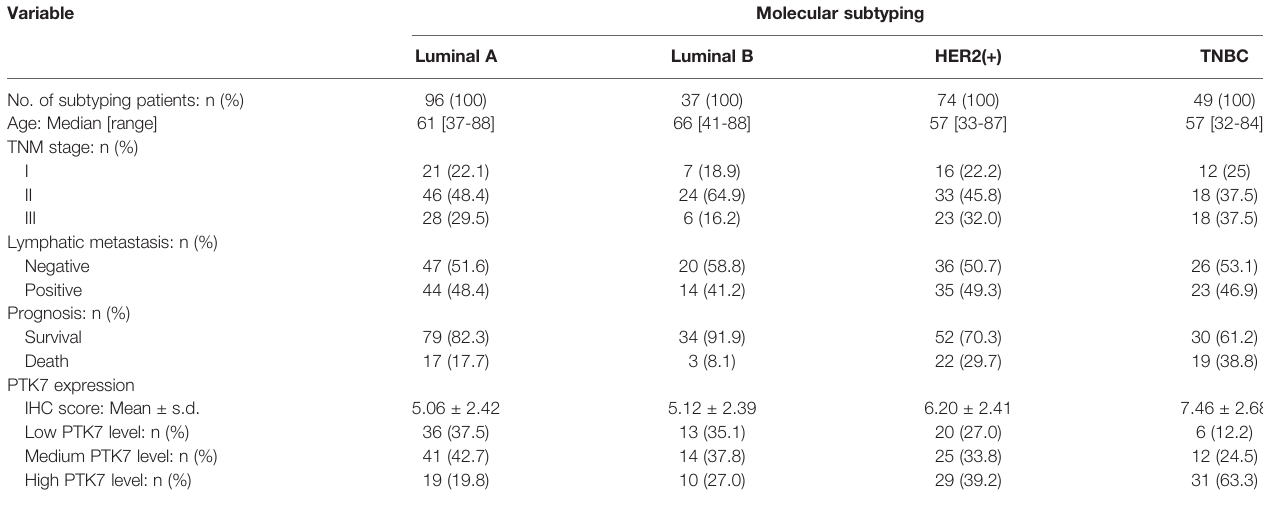
TABLE 2 | Molecular subtyping and clinical